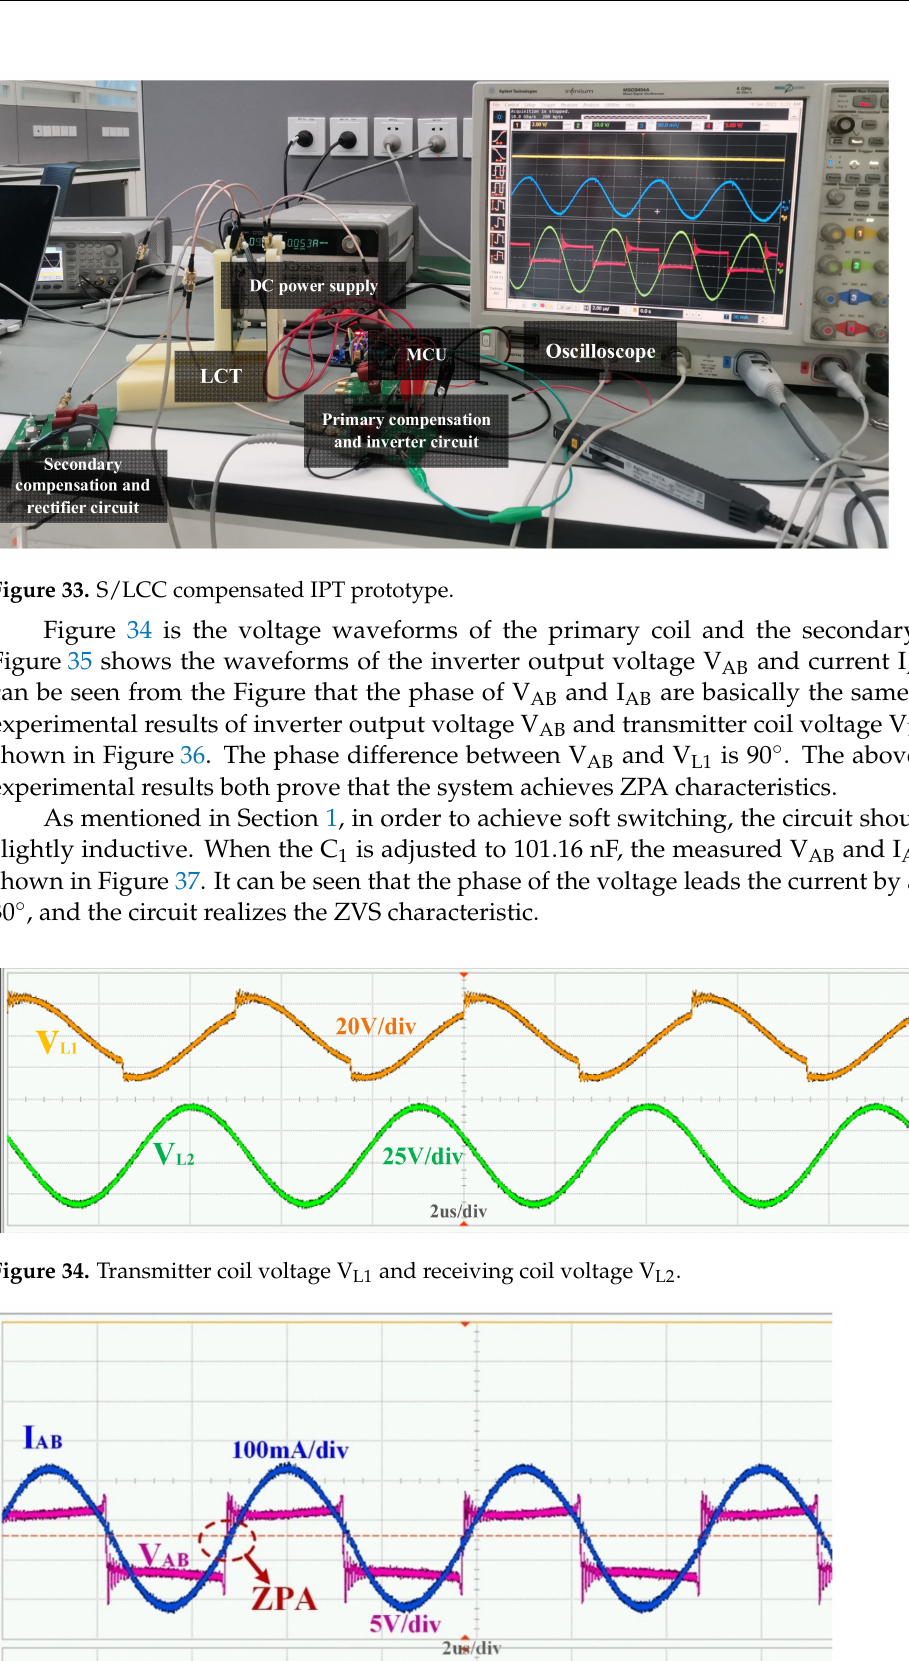
Figure 35. Inverter output voltage V AB and current I AB when